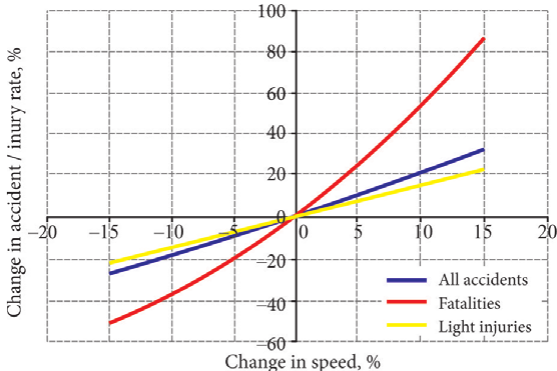
Figure 2. The relationship between the change in the mean operating speed and accident rates (Elvik, 2009)